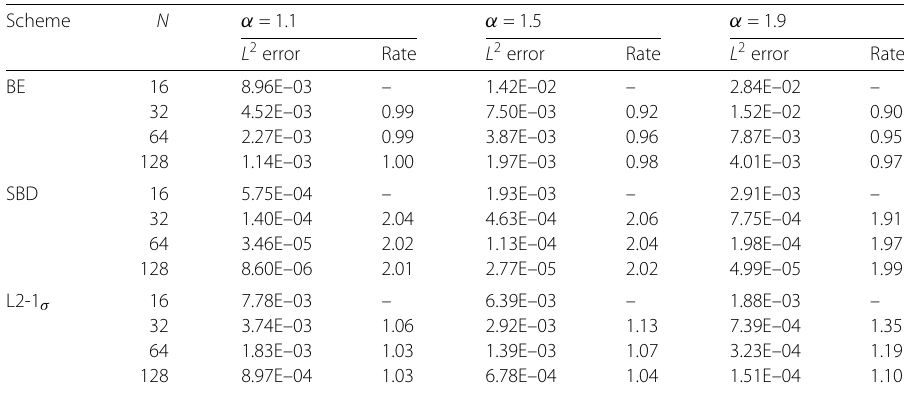
Table 4 The L 2 norm errors in time for case (b) in Example 6.2 with h = 1/10